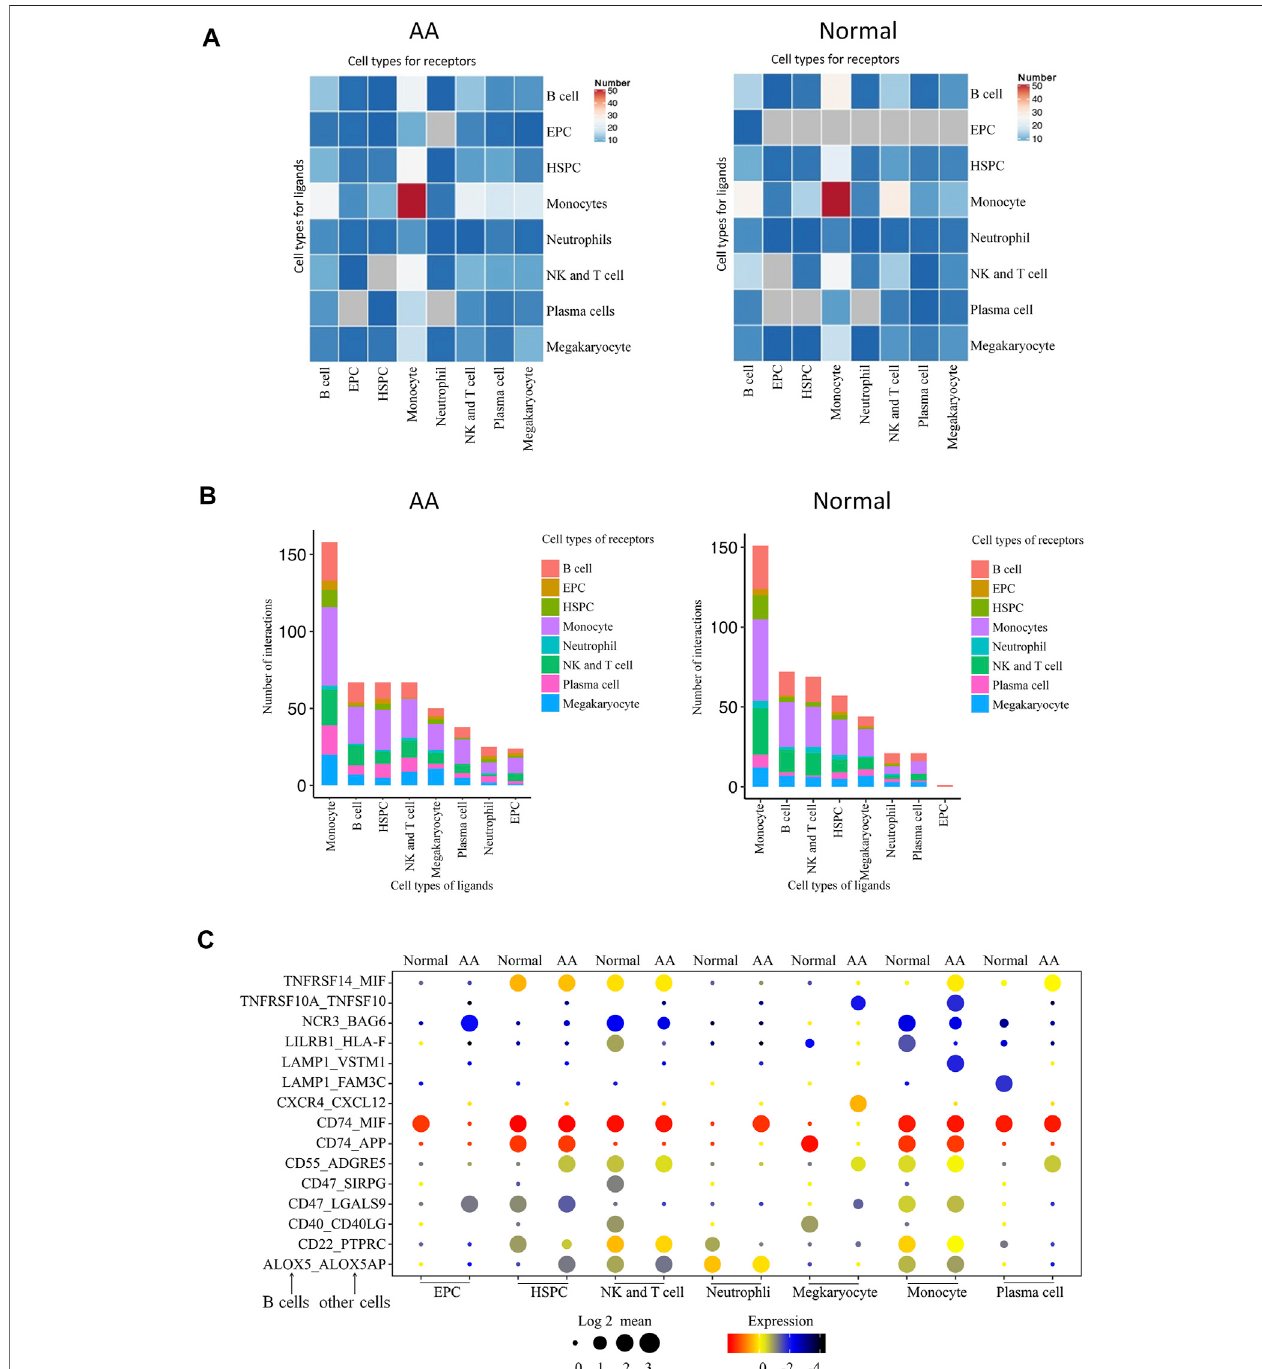
FIGURE 7 | Molecular interaction of B cells with hematopoietic cells in the bone marrow. (A) Heatmap of the pairs of interactions between different cells. (B) Stackedbarsoftheligand – receptorpairsinteractingbetweencells. (C) Spectrumofligand – receptorpairsbetweenBcells(columns)andhematopoieticcells(rows).Dot sizes and colors represent logarithmic-transformed P values and mean expression of interacting molecules in corresponding cells.